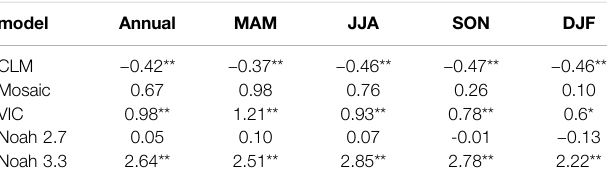
TABLE 1 | Linear trends (mm/a) of the soil moisture of the fi ve models at annual and seasonal scales during the period of 2000 – 2017. model